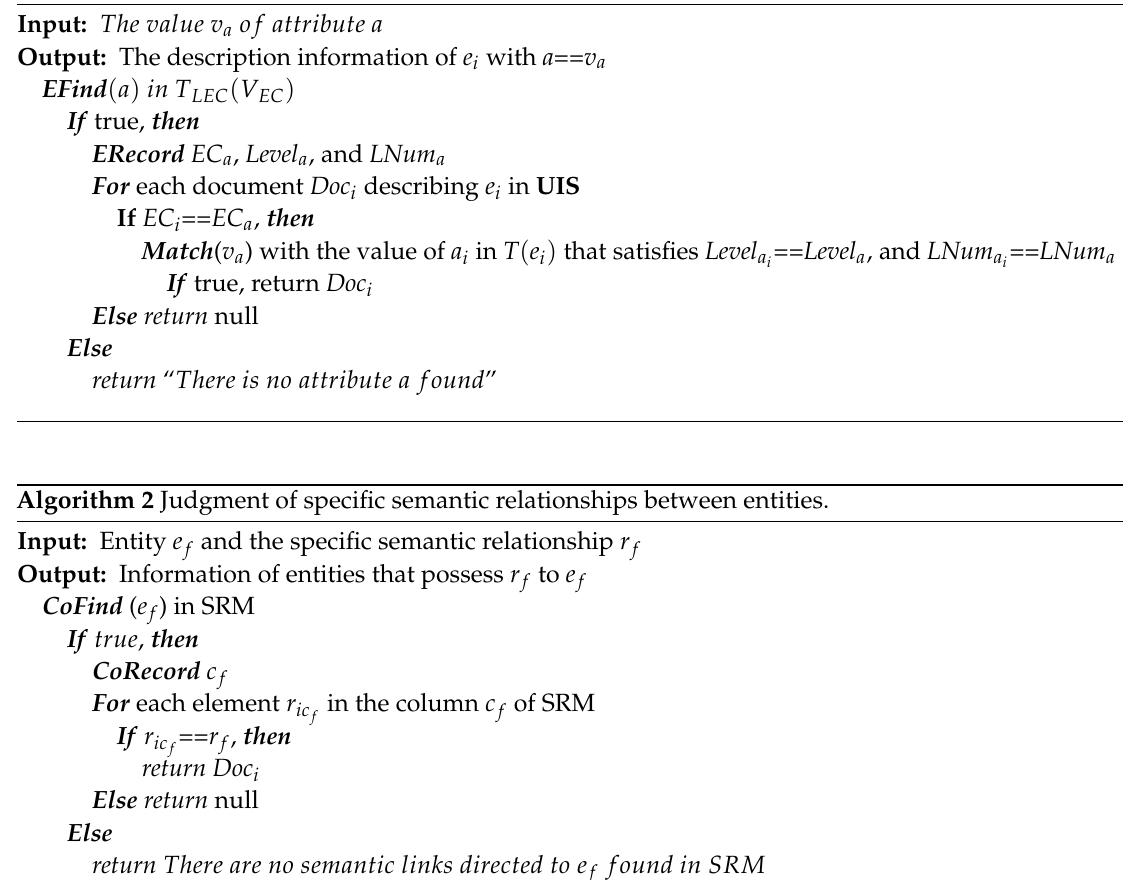
Algorithm 1 Query of entity description information in UIS.